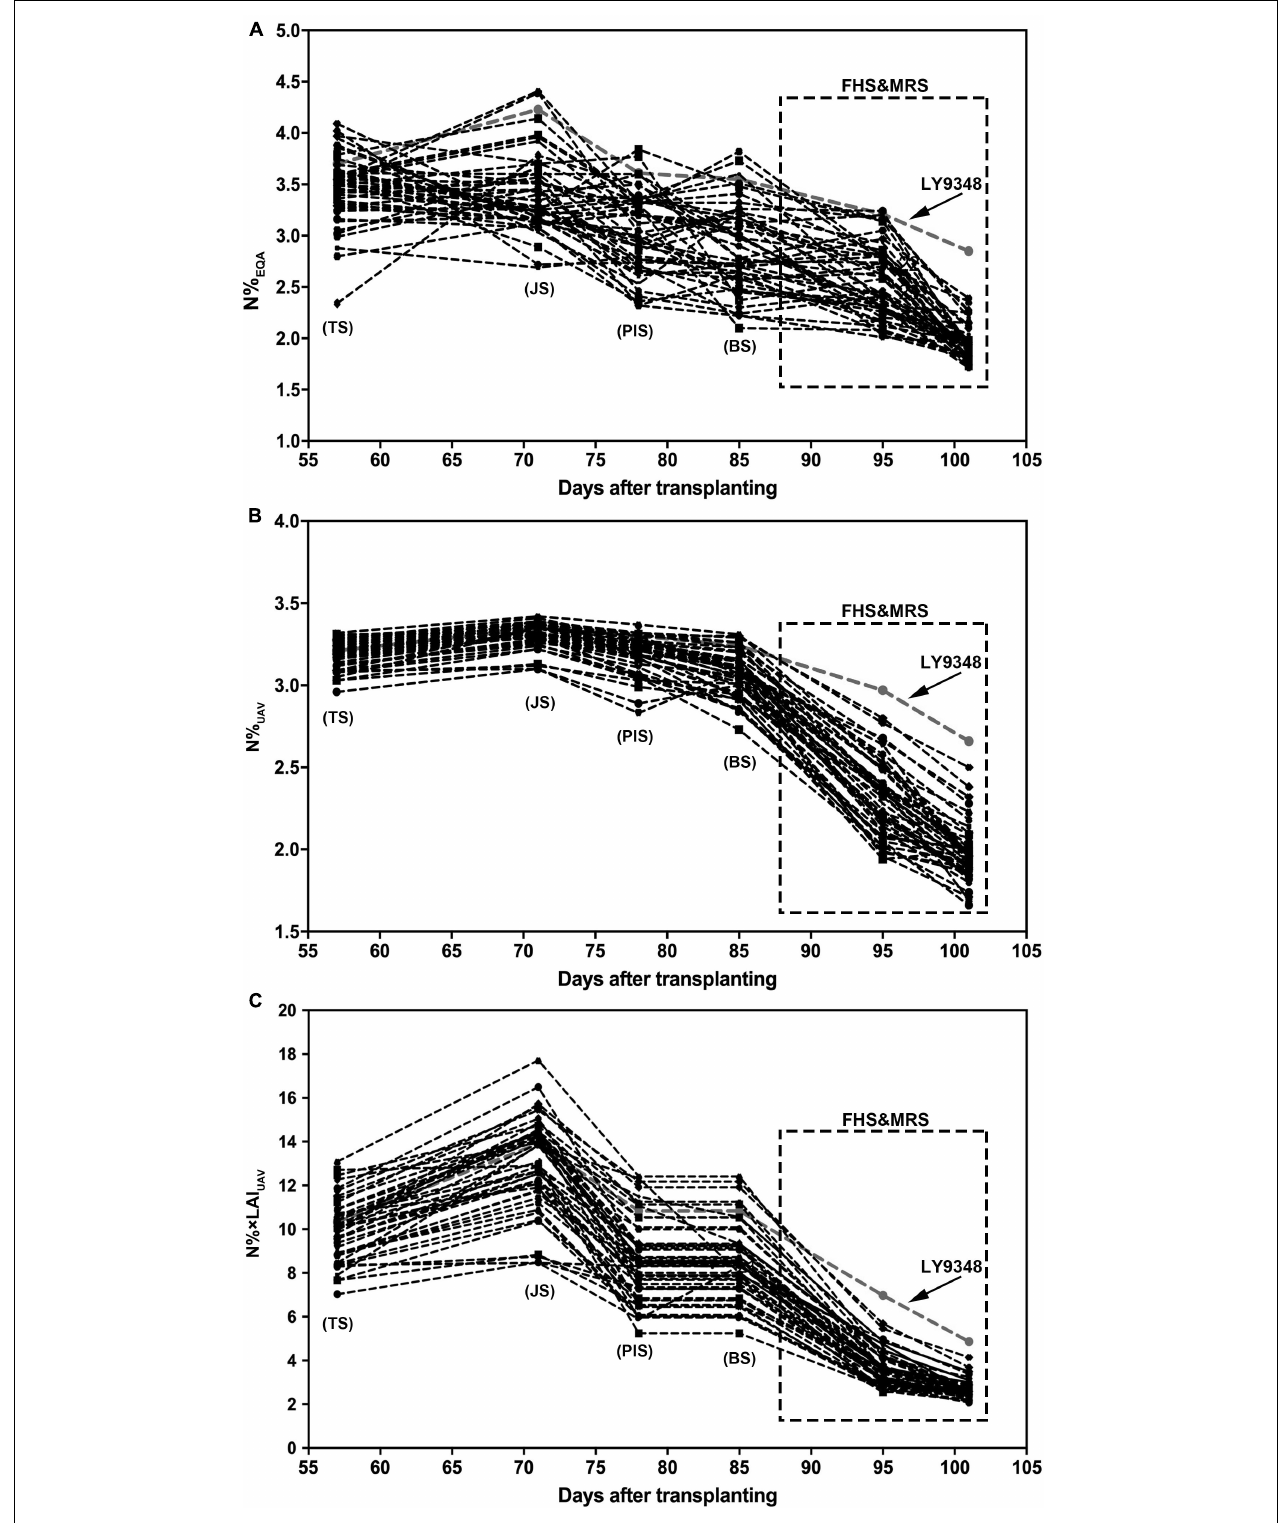
FIGURE 8 | The nitrogen accumulation dynamic curve of 51 rice varieties through the entire growth duration by actual measurement (N% EQA , A ) and estimation by Model I (N% UAV , B ) and Model II (N% × LAI UAV , C ). Model I: y = 5.75 × 2 + 8.17x + 0.58, x : NDRE UAV ; y : N% UAV . Model II: y = 1.06e 4 . 57x , x : NDRE UAV ; y : N% × LAI UAV . FHS and MRS are highlighted by the square